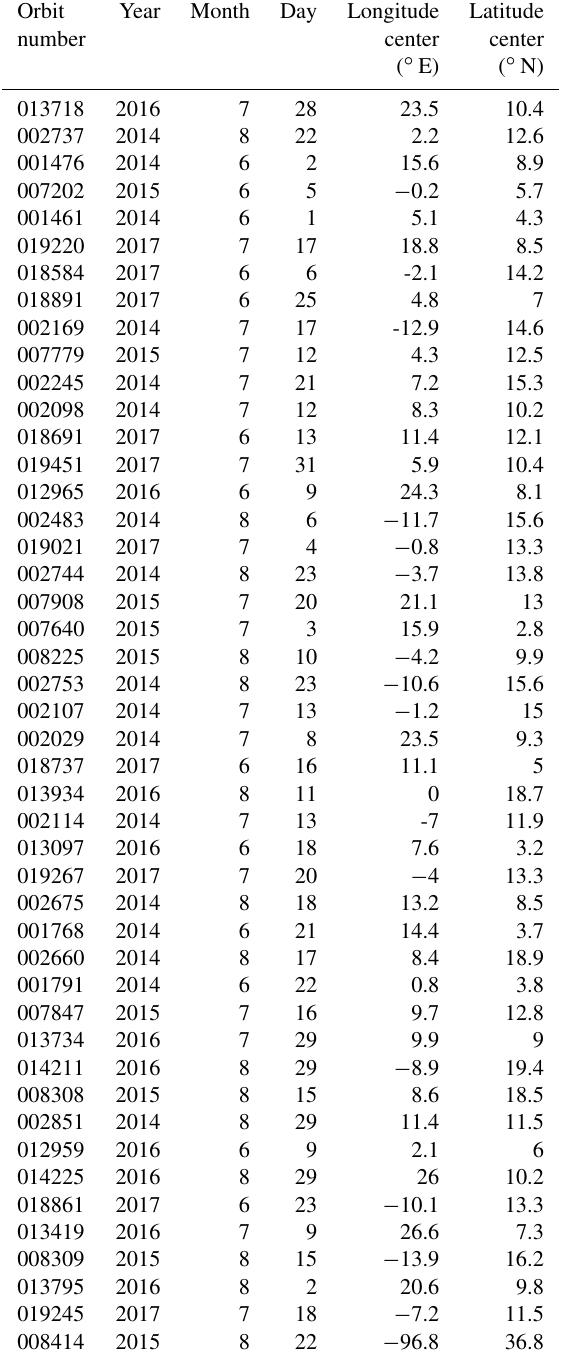
Table A1. Details about the 47 squall line cases we selected. The first column lists the GPM orbit number. The second–fourth columns include year, month and day of the event, and the last two columns are the longitude and latitude of the reference center (i.e., black rectangle in Fig. 8 for easy comparison, not necessarily the storm